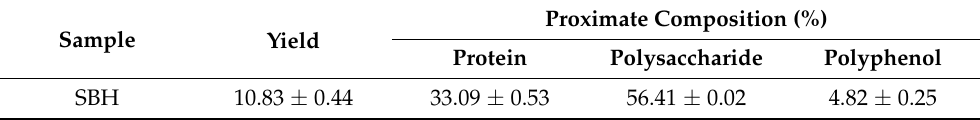
Table 1. Yield and proximate composition of SBH.